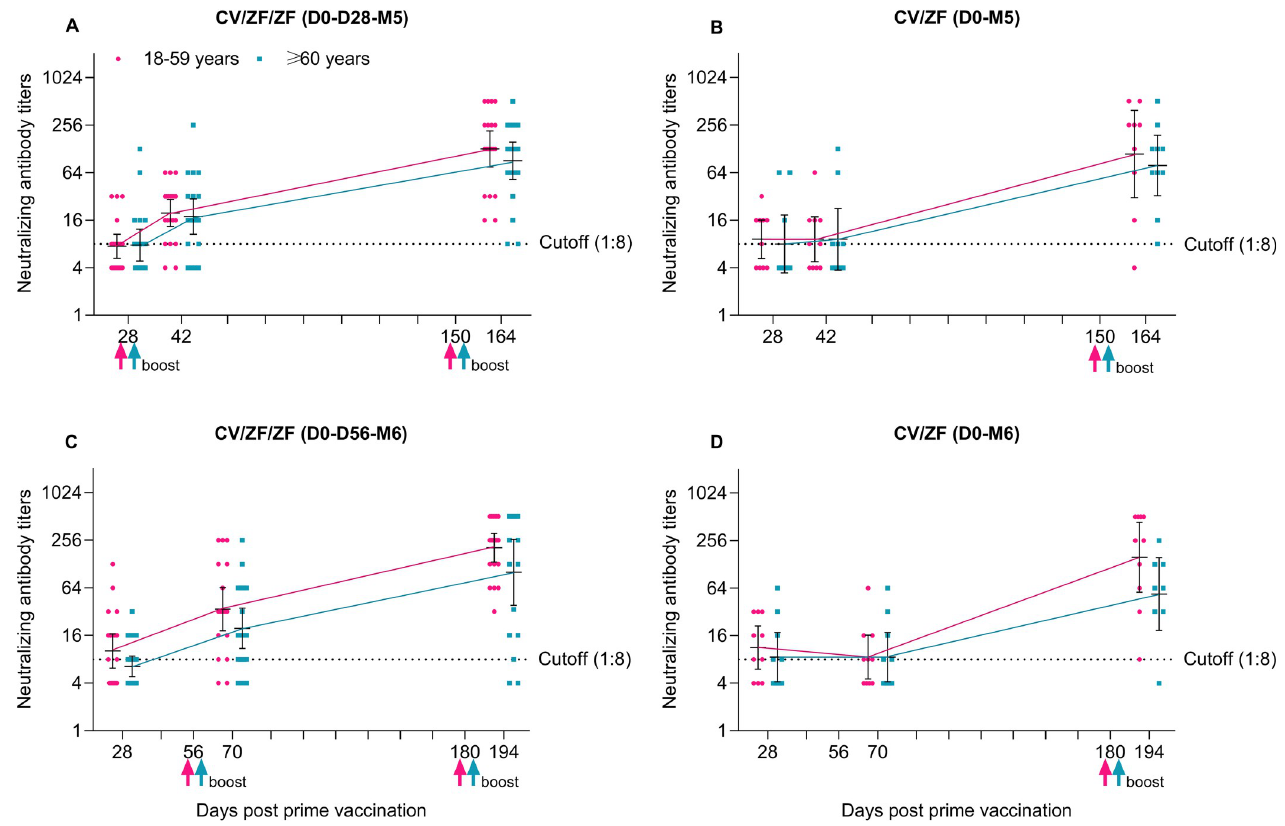
Fig 3. Neutralizing antibodies to wild-type SARS-CoV-2 after prime and boost dose according to age. Data presented are neutralizing antibodies to wild- type SARS-CoV-2 28 days after prime dose, 14 days after first and second boost according to age (18–59 years and � 60 years) in each regimen. Cutoff (1:8) refers to the detection limit. Horizontal bars show geometric mean titer and error bars show 95% CI. Up arrow represents the boost immunization. CV/ZF/ZF (D0-D28-M5) = receiving Convidecia/ZF2001/ZF2001 at day 0, day 28, and month 5; CV/ZF (D0-M5) = receiving Convidecia/ZF2001 at day 0 and month 5; CV/ZF/ZF (D0-D56-M6) = receiving Convidecia/ZF2001/ZF2001 at day 0, day 56, and month 6; CV/ZF (D0-M6) = receiving Convidecia/ZF2001 at day 0 and month 6. CI, confidence interval; SARS-CoV-2, Severe Acute Respiratory Syndrome Coronavirus 2.